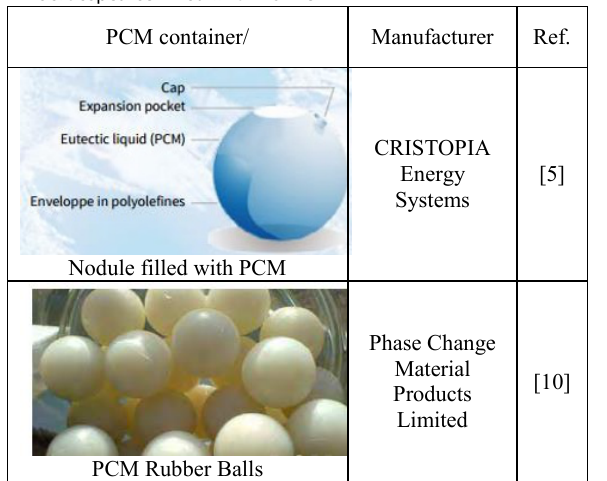
two experimental configuration: figure 1 - with higher packing factor, figure 2 – with higher heat transfer